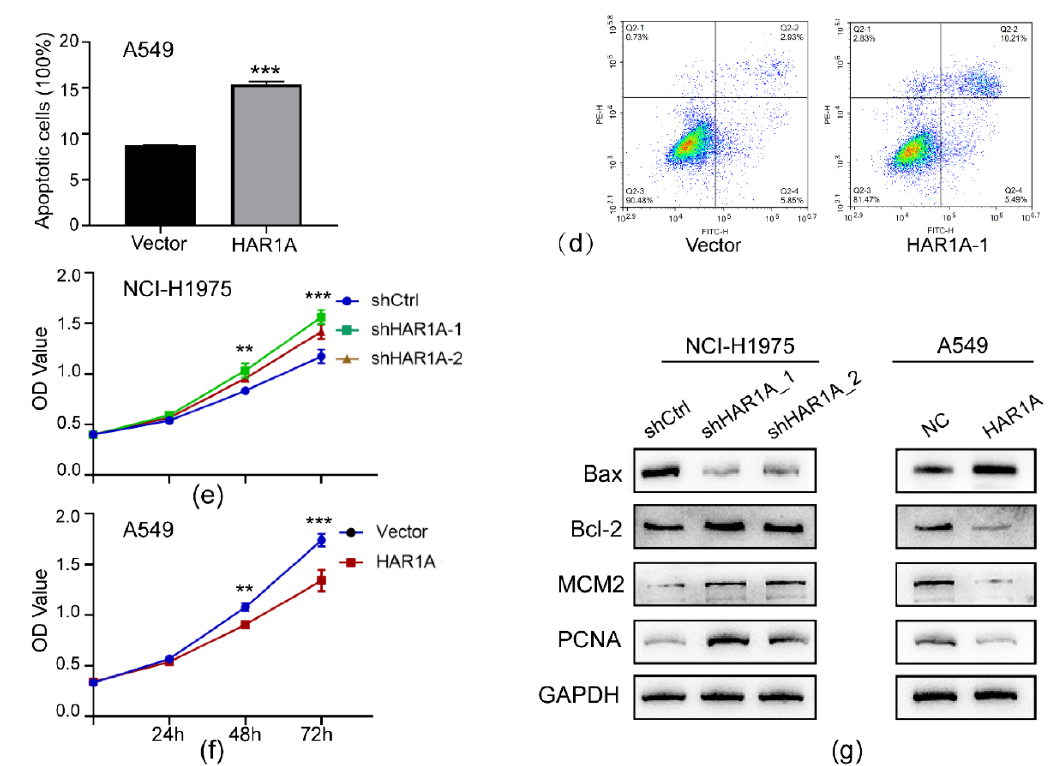
Figure 6. lncRNA HAR1A promoted apoptosis and inhibited the proliferation of NSCLC cells. ( a ) The expression levels of lncRNA HAR1A in five NSCLC cell lines as well as normal lung epithelial cells by qRT-PCR. ( b ) qRT-PCR results confirmed loss or gain function of lncRNA HAR1A in NCI-1975 and A549 cells. Impacts of the knockdown ( c ) of overexpression ( d ) of lncRNA HAR1A on apoptosis of NSCLC cells. After Annexin V and PI double staining, the percentage of apoptotic cells was estimated using flow cytometry. ( e ) The growth curve of A549 cells infected with lentivirus-mediated shRNA oligos targeting lncRNA HAR1A or scramble sequences (Ctrl). ( f ) The growth curve of A549 cells infected with empty vector (Ctrl) or lentivirus-mediated lncRNA HAR1A . Cell proliferation was determined by CCK-8 assay at 24, 48, and 72 h. ( g ) The expression of apoptotic (BAX and BCL-2) and proliferative (MCM2 and PCNA) biomarkers were examined in NSCLC cells by western blot. The experiment was performed in triplicate, and data were calculated from three independent experiments using statistical analysis. ** p < 0.01, *** p <